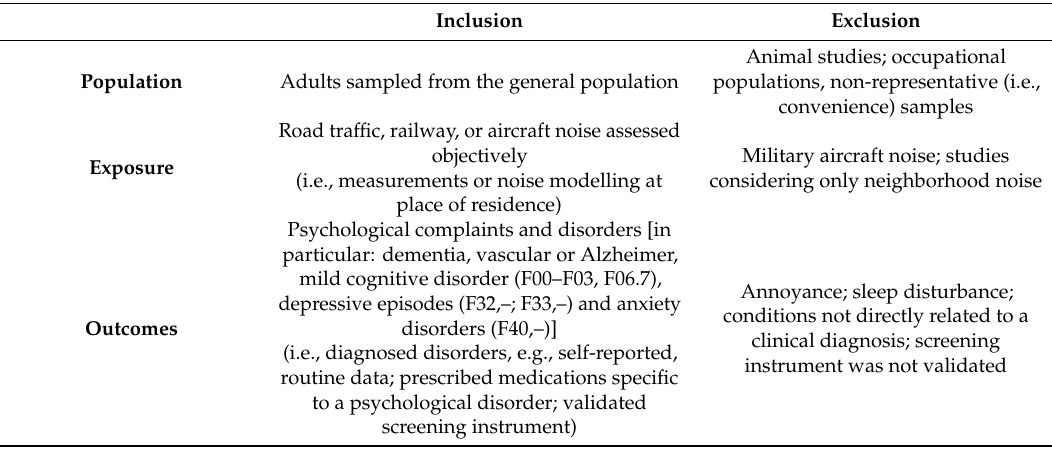
Table 1. Study inclusion and exclusion